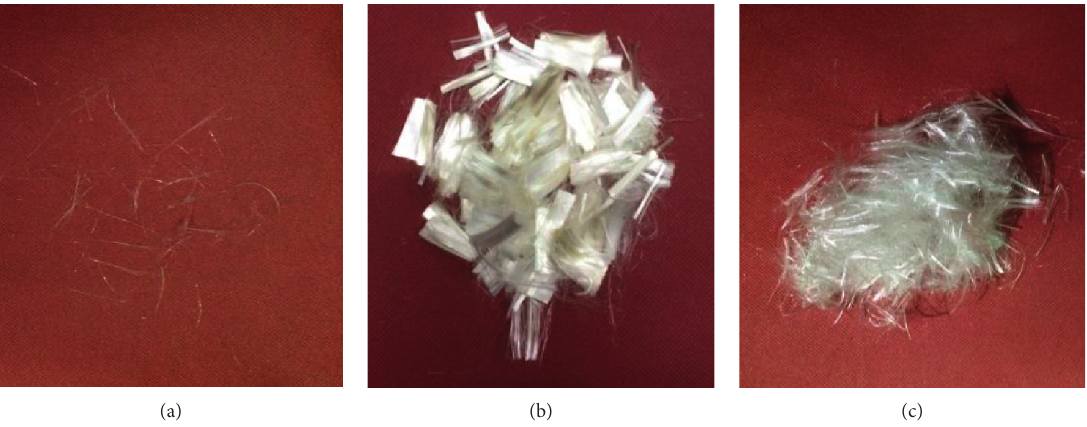
Figure 3: PVA fiber clustering: (a) monofilament, (b) bundle, and (c) reticulation.